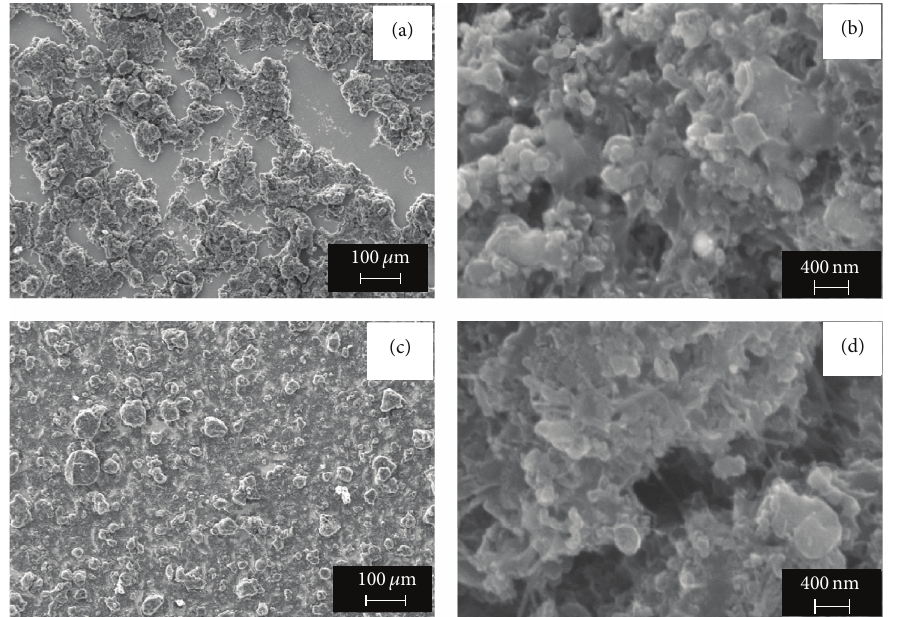
Figure 8: (a) The low and (b) the high magnification SEM images of the U-CNTs/ITO film. (c) The low and (d) the high magnification SEM images of the M-CNTs/ITO film coated on the conductive plastic.